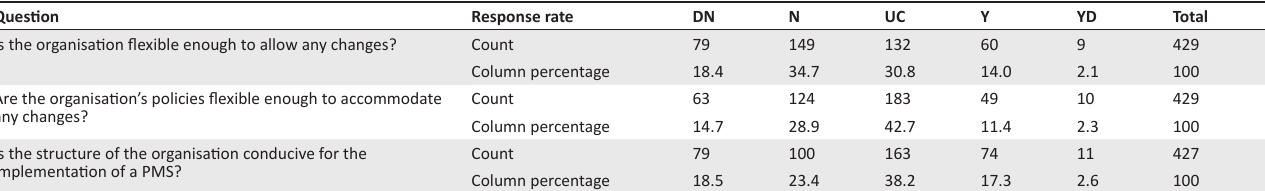
TABLE 8: Organisational structure and policies. Question